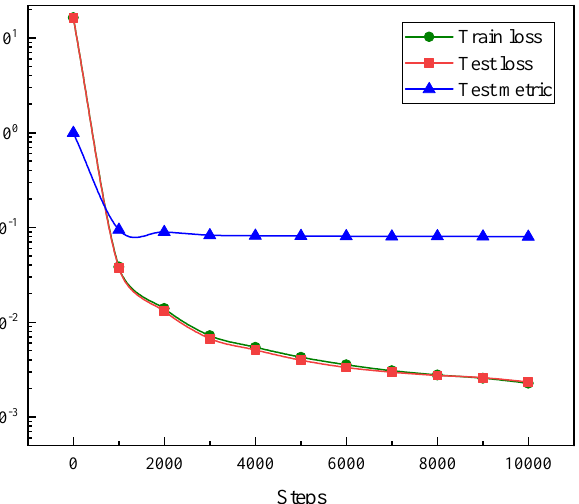
Figure 13. Mean squared error loss and test metric for two-dimensional consolidation model of drainage at the top and bottom boundaries.